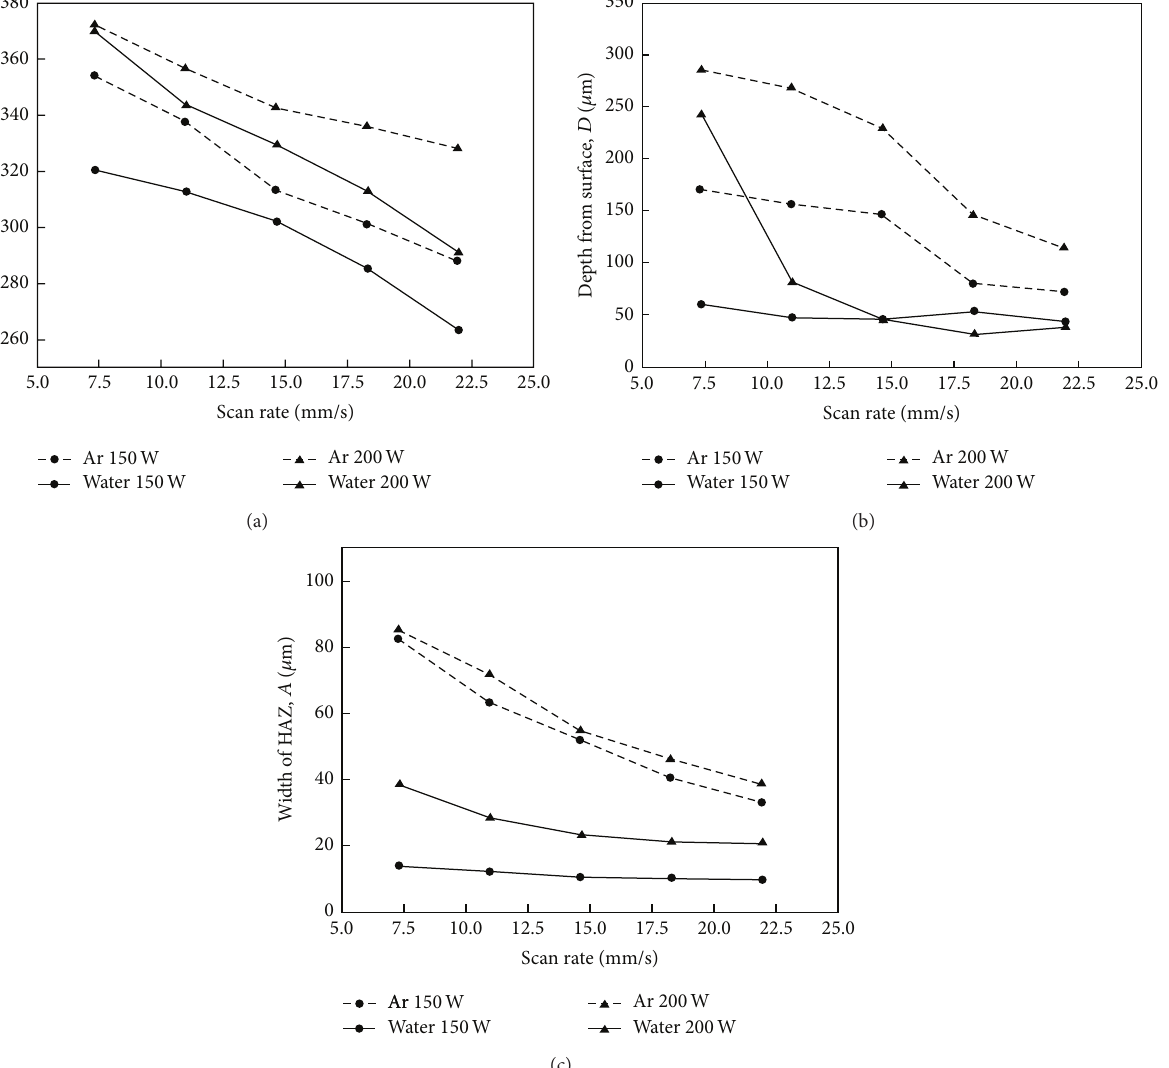
Figure 7: Comparisons of laser scan rate effects on (a) deposition width, (b) depth from surface, and (c) HAZ